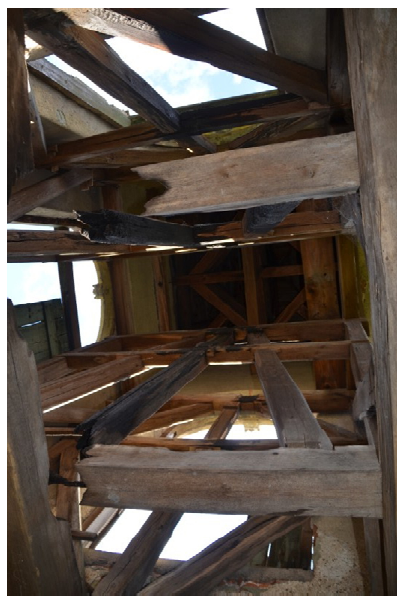
Figure 18. 3D model of